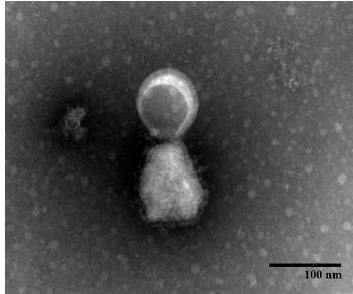
Figure 2. Electron micrograph of the recombinant virus. Recombinant viruses were stained with 1% PTA and analysed by TEM. Scale bar, 100